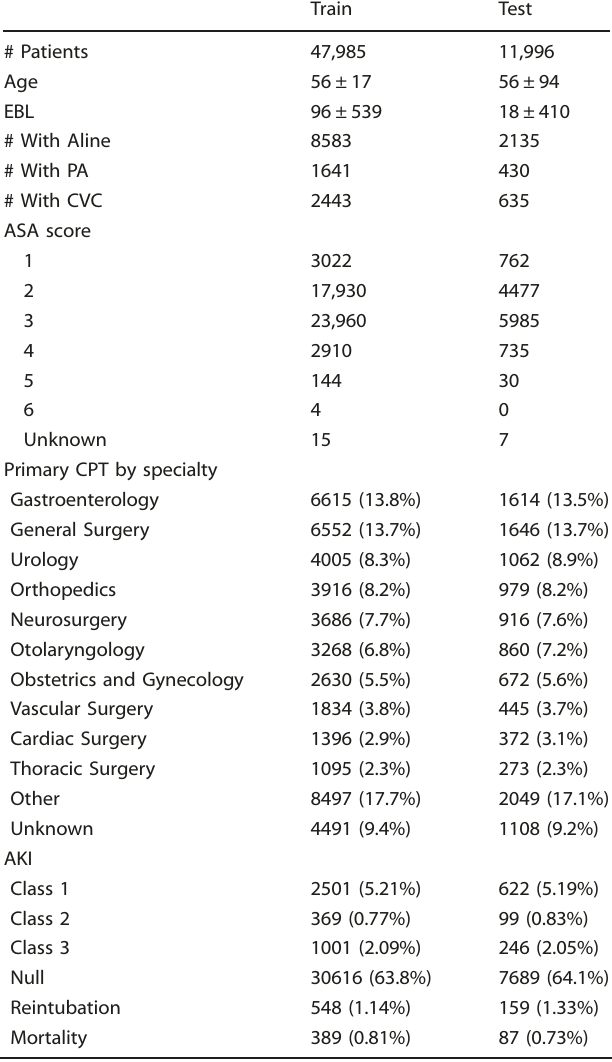
Table 1. Description of demographic